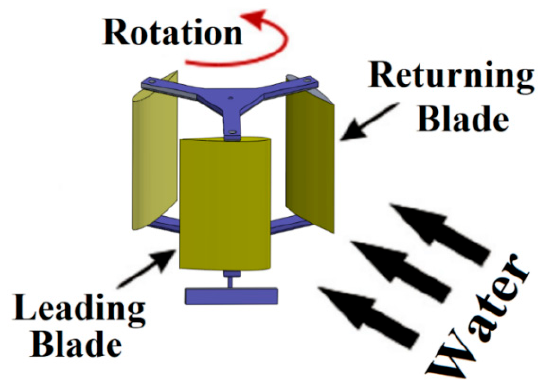
Figure 1. Schematic of the Darrius hydro (DH) turbine.